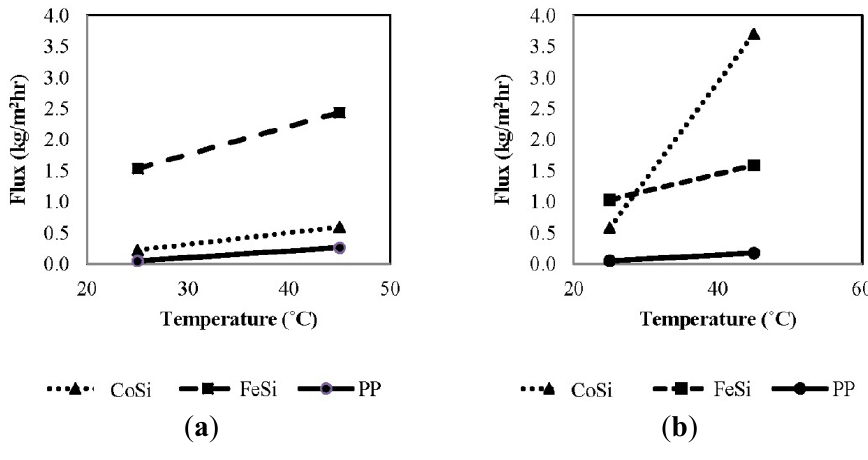
, of the CoSi and FeSi membranes H2O/NH3